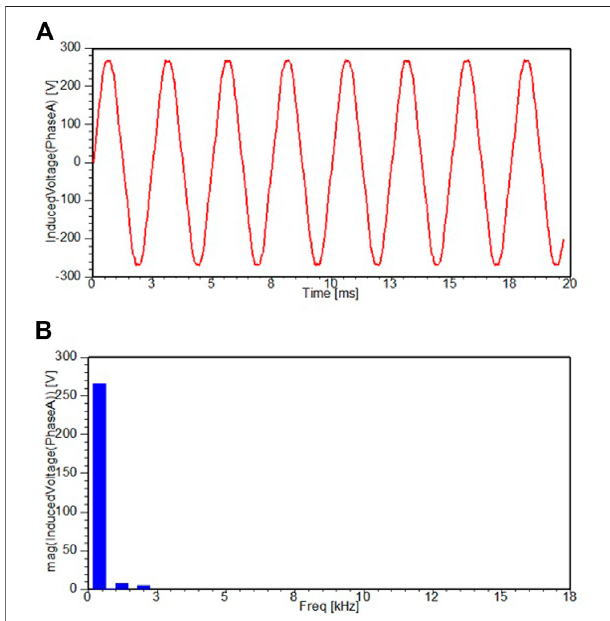
FIGURE 7 | Back electromotive force (EMF) of phase at no-load in the liquid nitrogen ( − 196 ° C): (A) no-load back EMF waveform; (B) Fourier decomposition of back EMF shown in (A) .